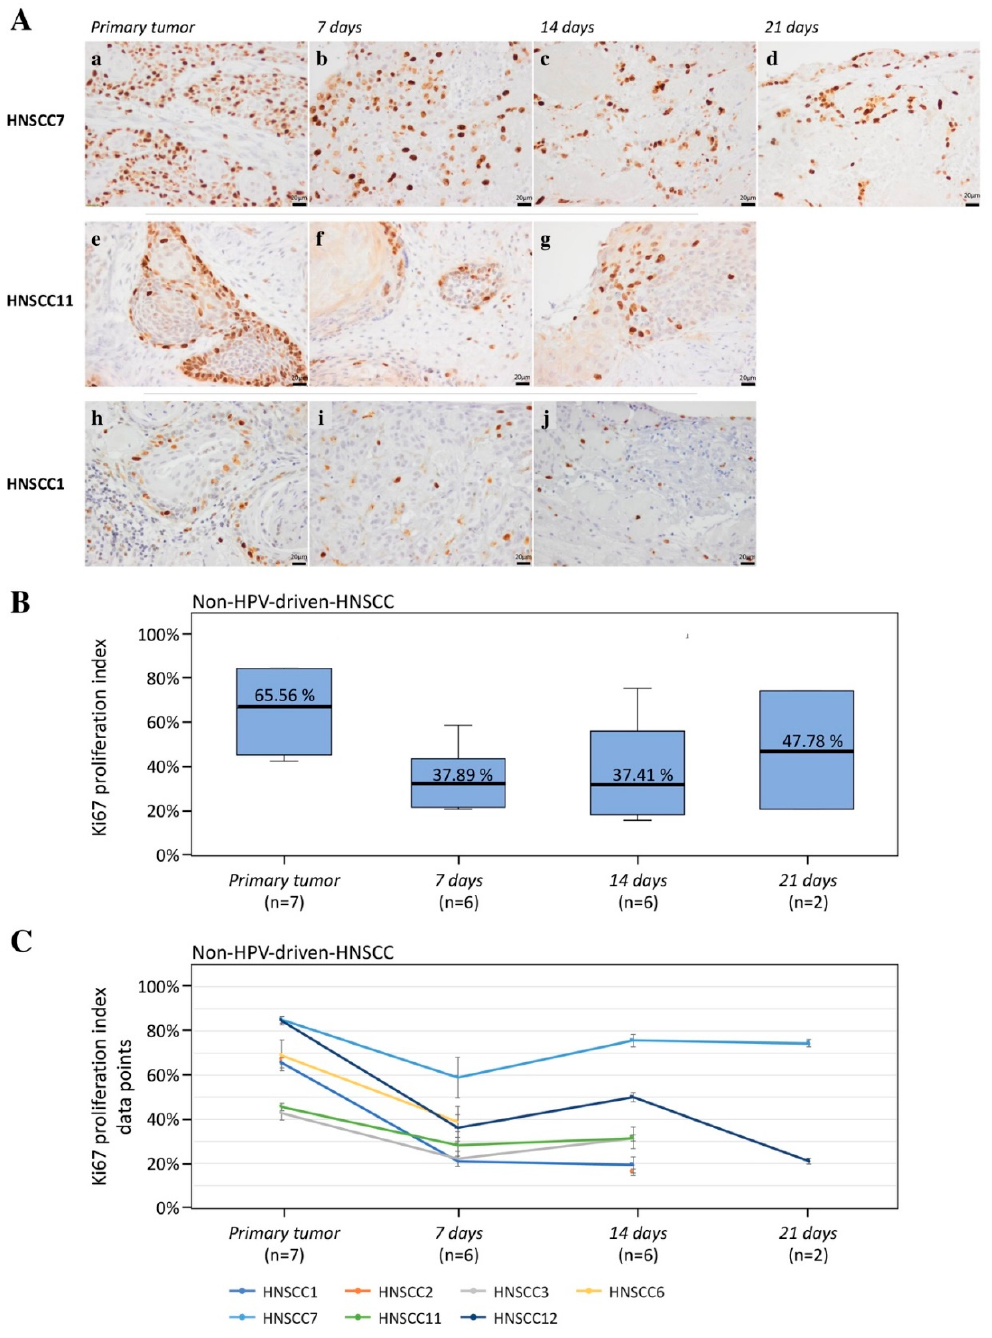
Figure 3. ( A ) Representative pictures of immunohistochemical staining with an anti-ki-67 antibody from three non-HPV-driven 3D-OTCs (b–f,h,i), kept in culture for the indicated periods of time, and corresponding primary tumors (a,d,g) to assess proliferation. HNSCC7 shows strong ki-67 expression in the primary (a). The proliferation index is only minorly reduced up to day 21 (b–d). HNSCC11 presents constant proliferation indices of proliferating tumor cells in primary (e) and 3D-OTCs [19]. Ki-67 expression in HNSCC1 (cid:48) primary is moderate (h) and presents with a visible decrease of the proliferation index up to day 14 (i,j). Scale Bar: 20 µ m. ( B ) Boxplot of ki-67 proliferation indices of primaries and 3D-OTCs on day 7, 14, and 21 of all non-HPV-driven HNSCC. ( C ) Mean values of ki-67 proliferation indices of all primaries and 3D-OTCs on day 7, 14, and 21 of all non-HPV-driven HNSCC. Error bars indicate standard errors of the mean. Abbreviations: HPV, human papillomavirus; 3D-OTC, 3D organotypic co-culture; HNSCC, head and neck squamous cell